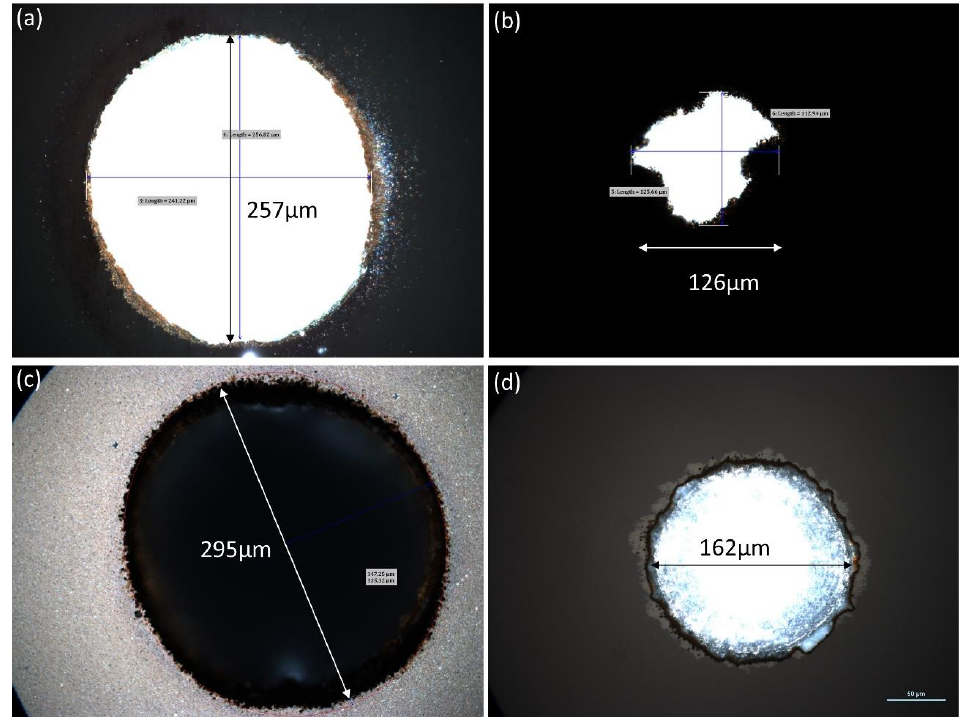
Figure 8. Microscope images of laser-drilled through holes. ( a , c ) correspond to the front surface and ( b , d ) to the rear surface. Different hole diameters are presented. Table 2. Laser and scanning parameters for silicon